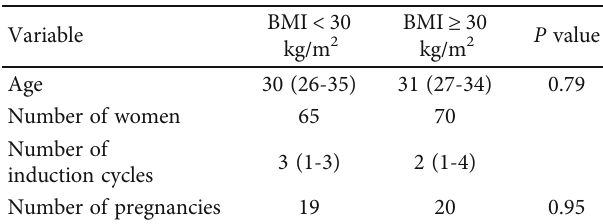
Table 1: Demographic and clinical data for women undergoing ovulation induction with letrozole+FSH-containing